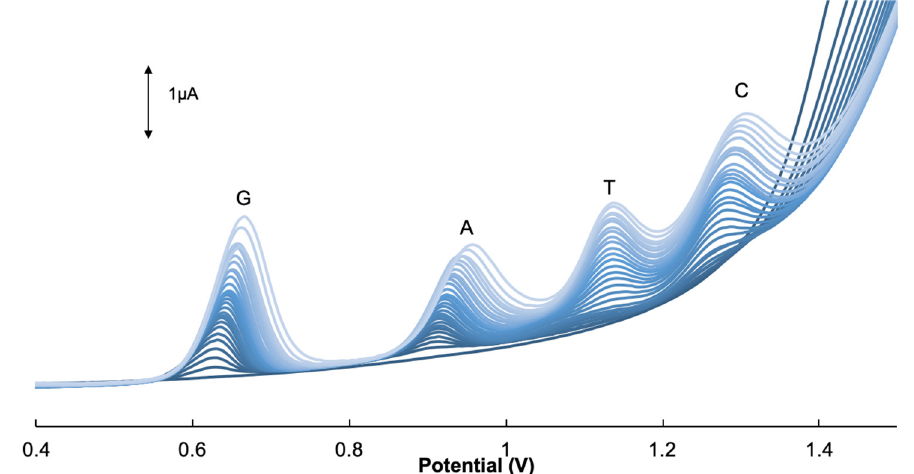
Figure 6. Differential pulse voltammograms of GCE/GONRs-CH in the presence of mixed solutions with G (0.05–256 µ M), A (0.05–172 µ M), T (5.0–855 µ M) and C (2.5–342 µ M) in 0.1 M PBS (pH 7.0). Table 1. Summary of the calibration curve and the R 2 values of the linear fit, the limit of detection and the dynamic range for the electrochemical detection of four nucleobases using GCE/GONRs-CH.